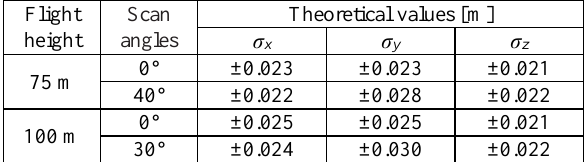
Table 3. Theoretical values